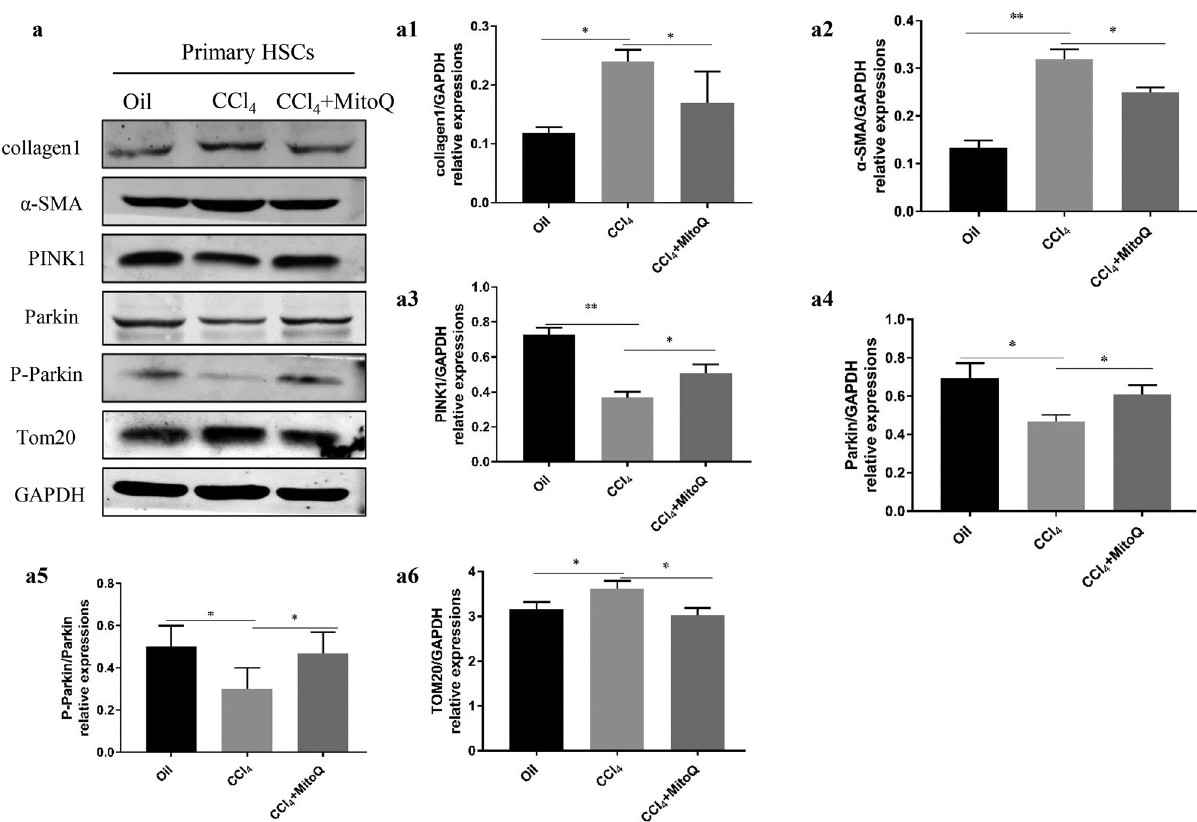
Figure 2: Mitophagy decreases with the activation of HSCs, and MitoQ enhances mitophagy. ( a ) Western blot analysis shows the collagen 1, α - SMA, PINK1, parkin, P - parkin, and TOM20 expression in the primary HSCs. ( a1 ) Columns represent the gray - scale value of collagen 1 expression. ( a2 ) Columns represent the gray - scale value of the α - SMA expression. ( a3 ) Columns represent the gray - scale value of PINK1 expression. ( a4 ) Columns represent the gray - scale value of parkin expression. ( a5 ) Columns represent the gray - scale value of P - parkin expression. ( a6 ) Columns represent the gray - scale value of TOM20 expression. Data show the mean ± standard deviation. Experiments were repeated three times. * P < 0.05, and ** P <